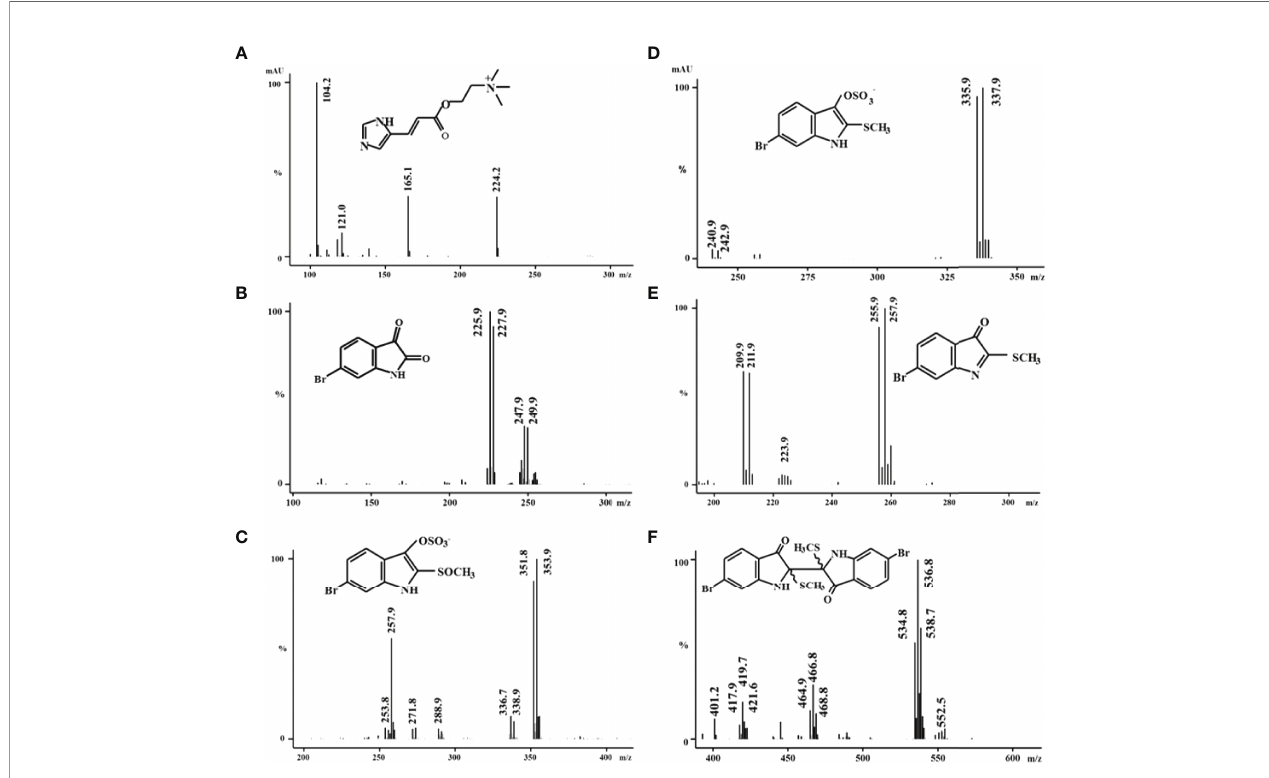
FIGURE 3 | Representative mass spectra of the secondary metabolites obtained from ethanol extracts from the hypobranchial gland of Dicathais orbita (A) murexine, (B) 6-bromoisatin, (C) tyrindoxyl S-oxide sulphate, (D) tyrindoxyl sulphate, (E) tyrindoleninone, and (F) tyriverdin.